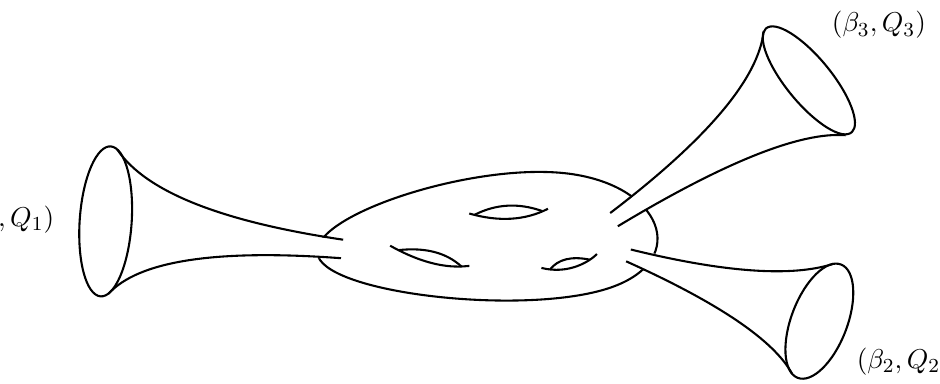
Figure 1 . Cartoon of the geometry that computes Z g,n ( { β i } , { Q i } ) . At the end of each trum- pet i , we specify the boundary conditions β i and Q i , which corresponds to the insertion of Tr e − β i ( H + Q 2 i / (2 γ ) ) in the matrix